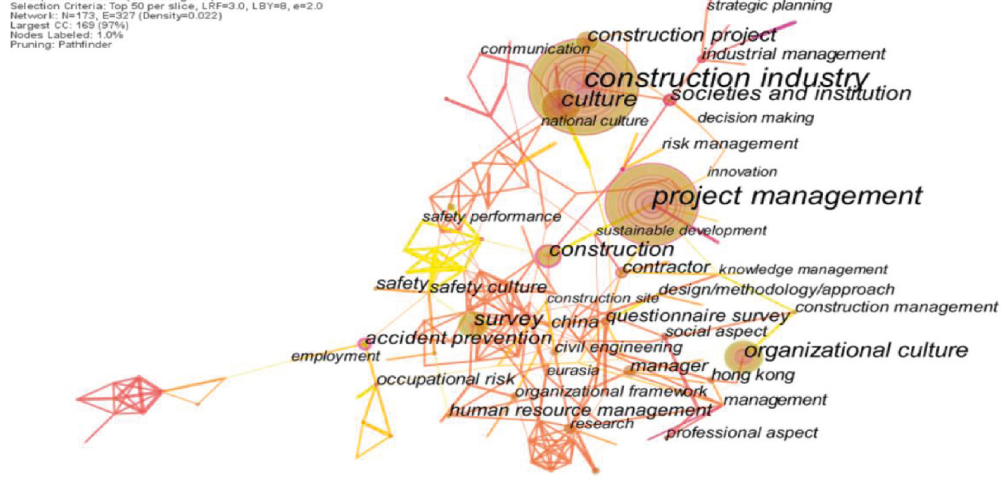
Figure 6: Top keyword occurring more than ten times: 1989–2022.